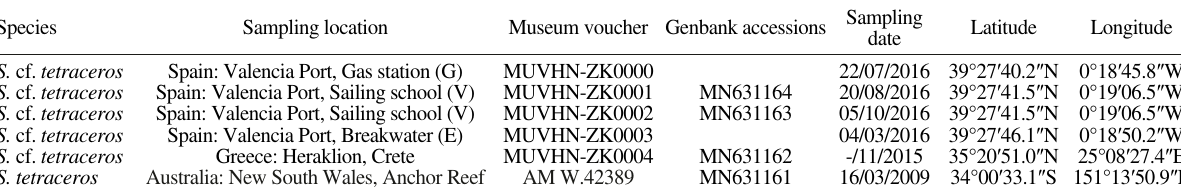
Table 1. – Specimens belonging to the S. tetraceros species complex analysed for the first time in the present study. Museum vouchers, GenBank accession numbers (cytochrome b sequences) and geographical origin are included. GenBank codes for Spirobranchus material from previous studies are shown in Figure 2. Museum abbreviations: MUVHN, Museu de la Universitat de València d’Història Natural; AM, Australian Museum.